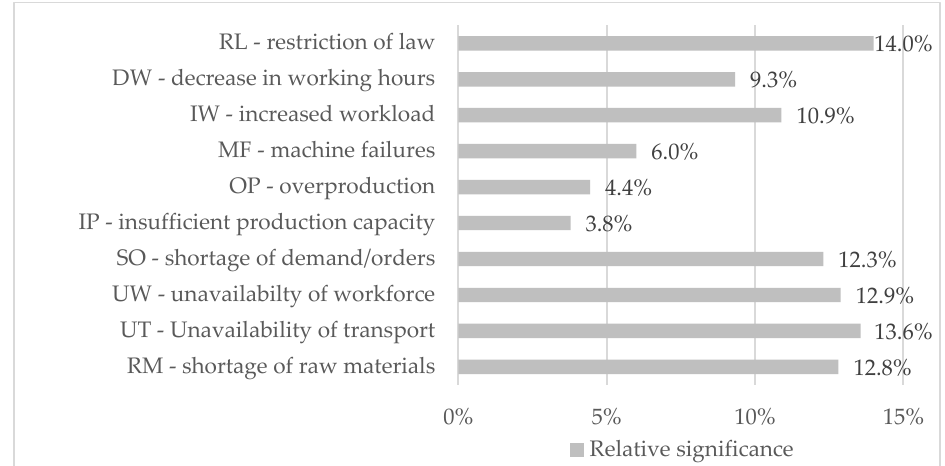
Figure 7. Relative significance of variables.